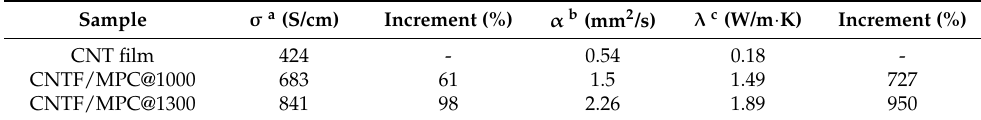
Table 4. The electrical and thermal conductivities of CNT film and CNTF/MPC nanocomposites.